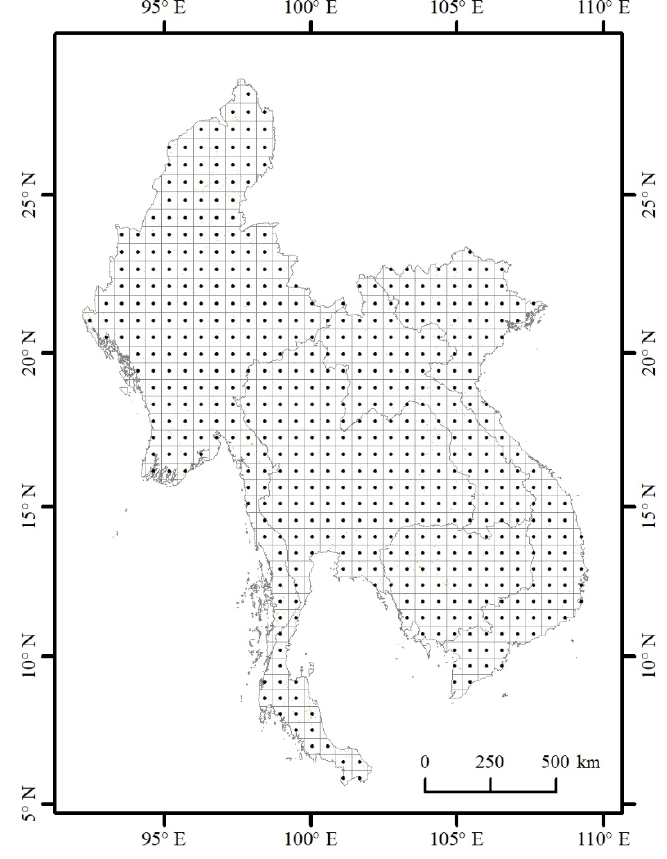
Figure 2. Distribution of LULC samples.